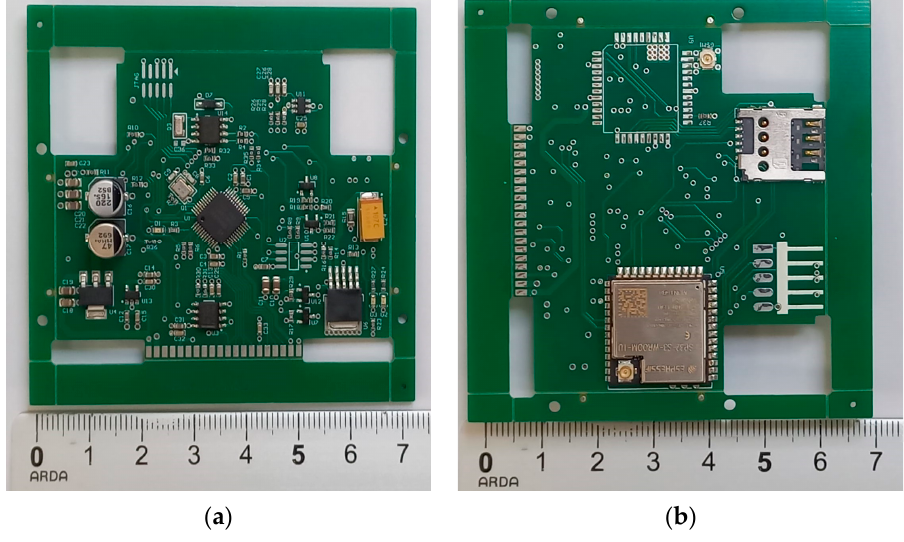
Figure 8. The SunSpec adapter, ( a ) front side and ( b ) back side. The SunSpec adapter acts as an interface between the home gateway and the storage system; it uses a wireless connection with the home gateway (using the ZeroConf protocol) and a wired connection with the storage system (RS485 serial port). SunSpec adapter are modified as shown in Figures 9 and